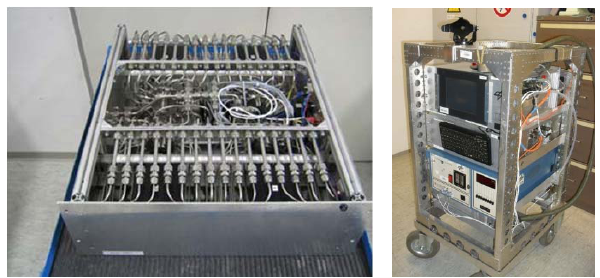
Figure 3. Adsorption tube set-up in the sampler ATS (left) and aircraft instrument rack including PERTRAS, ozone and CO instruments (right).